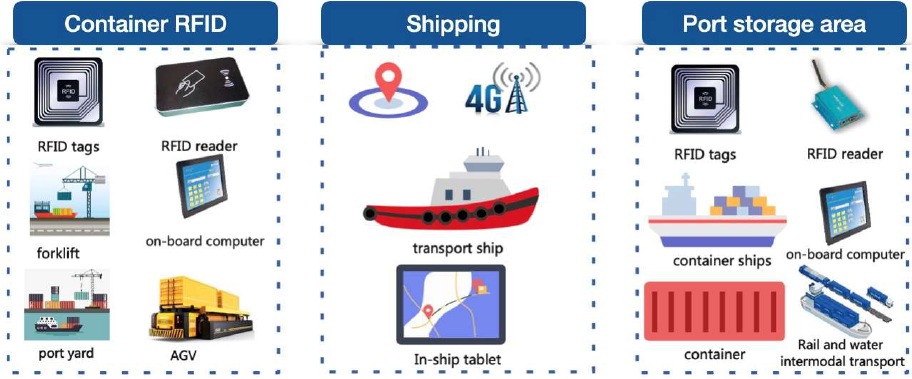
Figure 3. The IoT device deployment diagram for the inland river port logistics system. Table 1. The development status of the world’s cold chain container fleet composition.